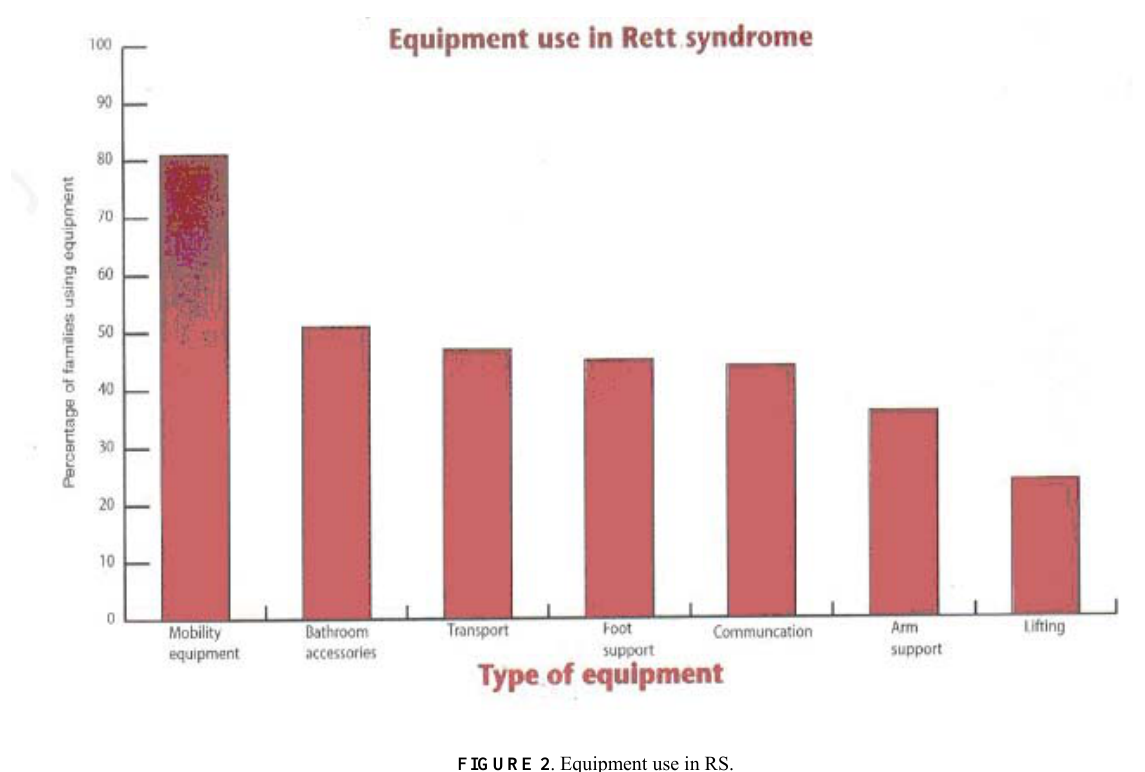
FIGURE 2 . Equipment use in